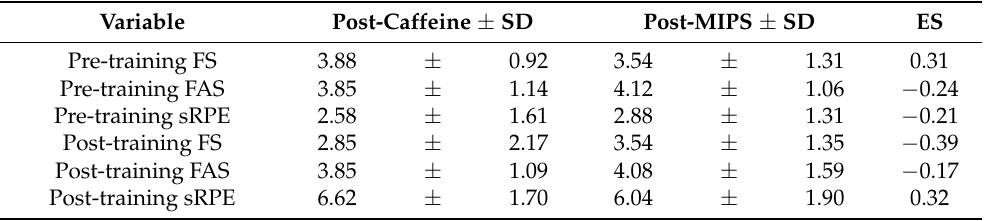
Table 3. Effects of caffeine and multi-ingredient pre-workout supplement (MIPS) ingestion on pre- and post-training feeling scale (FS), felt arousal scale (FAS) and session rating of perceived exertion